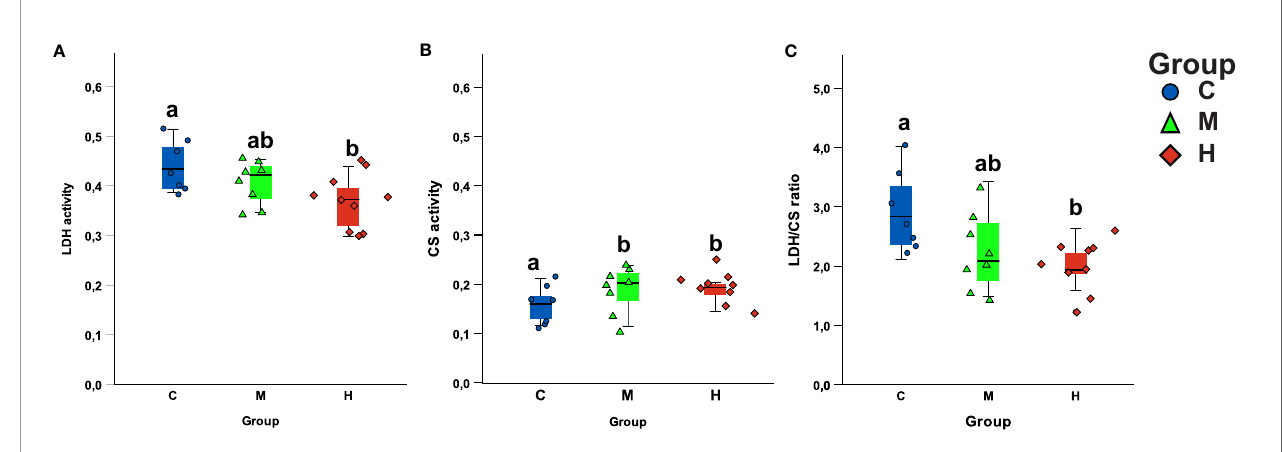
FIGURE 3 | The effects of training programmes on the enzymes activity in the ventricle. Boxplot of the maximal activity of the ventricular (A) lactate dehydrogenase (LDH) and (B) citrates synthase (CS) among training groups. (C) LDH/CS ratio. Different letters represent signi fi cant difference among